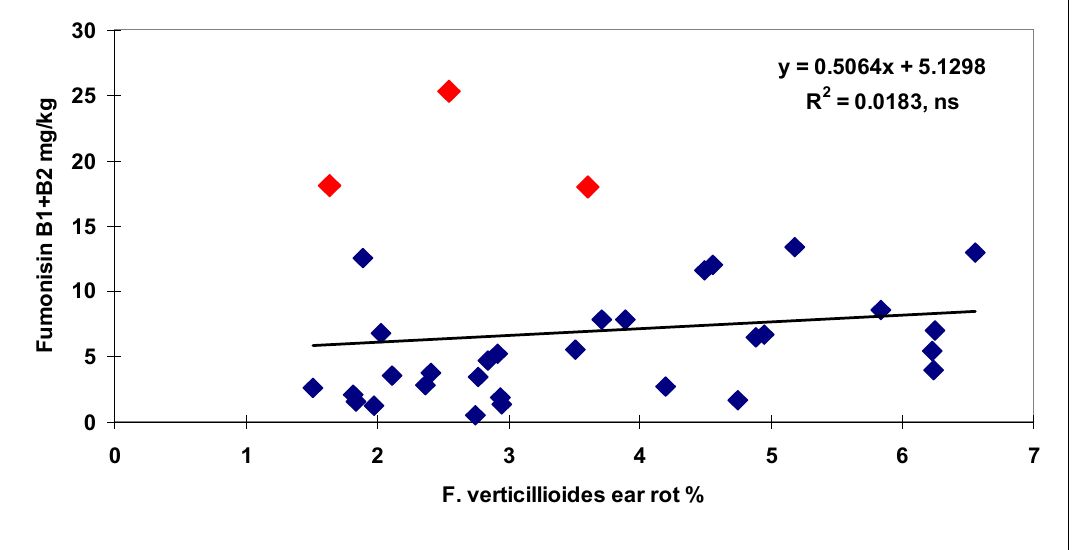
Figure 9. Regression between Fusarium verticillioides ear rot and fumonisin B1 + B2 contamination ( n = 34), means for natural and artificial infection from toothpick infection, Szeged, 2010–2011. LSD 5% for fumonisin B1 + B2 = 9.44. Red highlight: genotypes with significant fumonisin overproduction. In three hybrids (Szegedi SC 352, Kenez and Szegedi 475), the differences between ear rot and their corresponding data on the linear line were 12.08, 18.89 and 11, respectively, so a toxin overproduction could be verified.